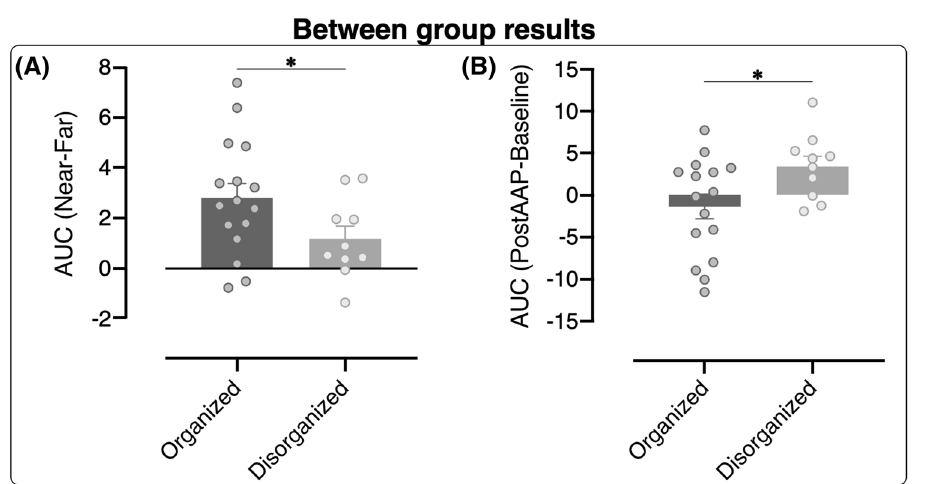
Figure 4. Between group results. ( A ) HBR position-dependent index expressed as Near-Far in the organized (dark grey) and disorganized (light grey) groups. ( B ) HBR AAP-dependent index expressed as AAP-Baseline in the organized (dark grey) and disorganized (light grey) groups. The error bars indicate standard error of the mean (SEM) and asterisk indicates the significant difference (*p < 0.05). The dots represent individual participants. The images were created with the following software: Matlab R2020b (https:// it. mathw orks. com/ produ cts/ matlab. html) and GraphPad Prism 8 (https:// www. graph pad. com/ scien tific- softw are/ prism/) were used to plot the data. Canvas Draw (https:// www. canva sgfx. com/ produ cts/ canvas- x- draw) was then used to combine all components of the figure into a single